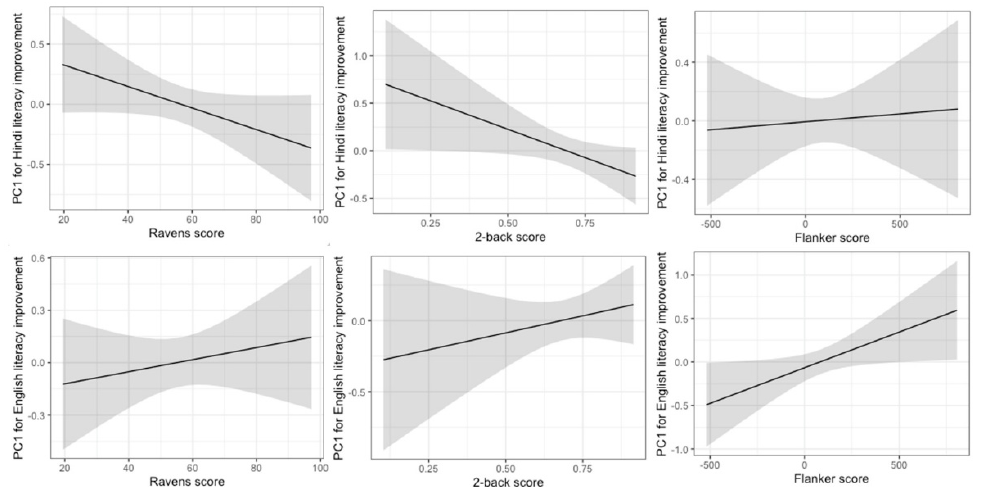
Figure 5. Relations between cognitive abilities and improvement in literacy performance from Std. 4 to Std. 5 in Hindi and English. Shaded areas indicate 95% confidence interval. A negative relation was found between improvement in Hindi literacy and 2-back score. A positive relation was found between improvement in English literacy and Flanker score (but note that lower scores on the Flanker task indicate better inhibitory skills).